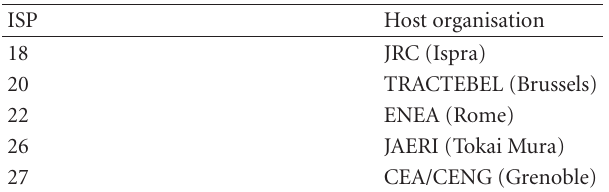
Table 3: List of host organisations for small break LOCA related